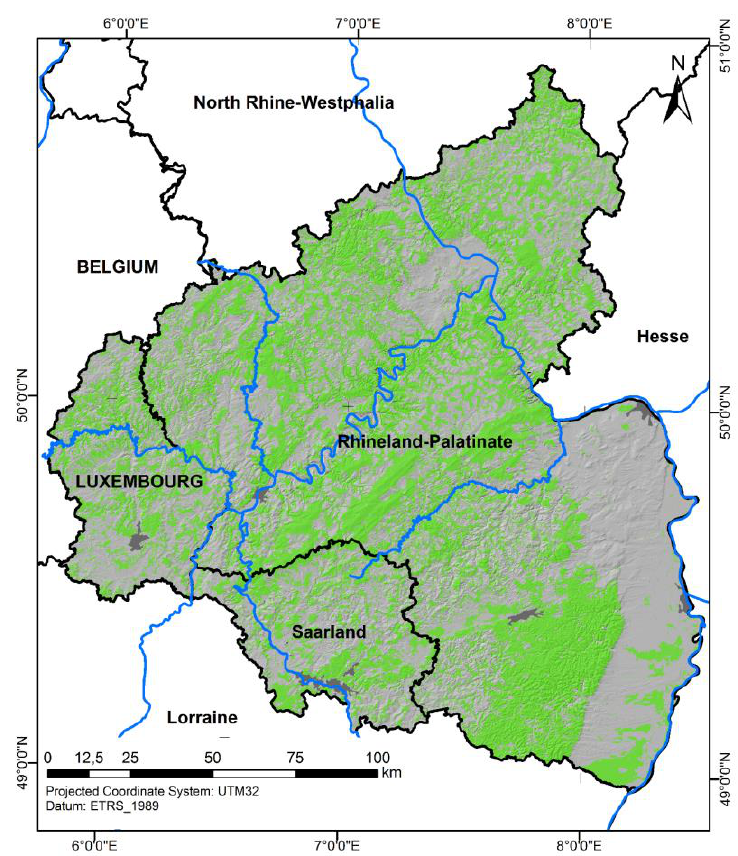
Table 1. Overview of the forest cover and proportional forest cover considering the forest type.